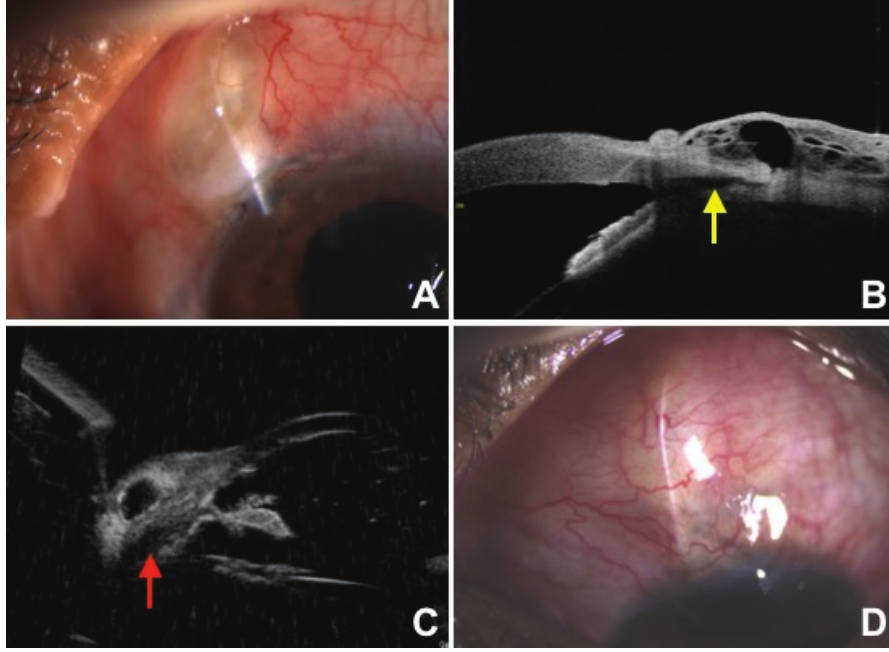
Figure 2. (A) Clinical photograph of case 1, six months postoperatively showing a diffuse, moderately elevated and mild vascular bleb. (B) ASOCT showing elevated cystic bleb with cyclodialysis cleft (yellow arrow). (C) UBM showing raised bleb with patent cyclodialysis cleft (red arrow). (D) Six months postoperative clinical picture of case 2 showing a diffuse, moderately elevated, and vascular